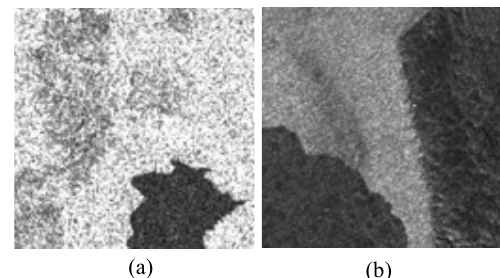
Figure 1. Real SAR images: (a) coastal image,